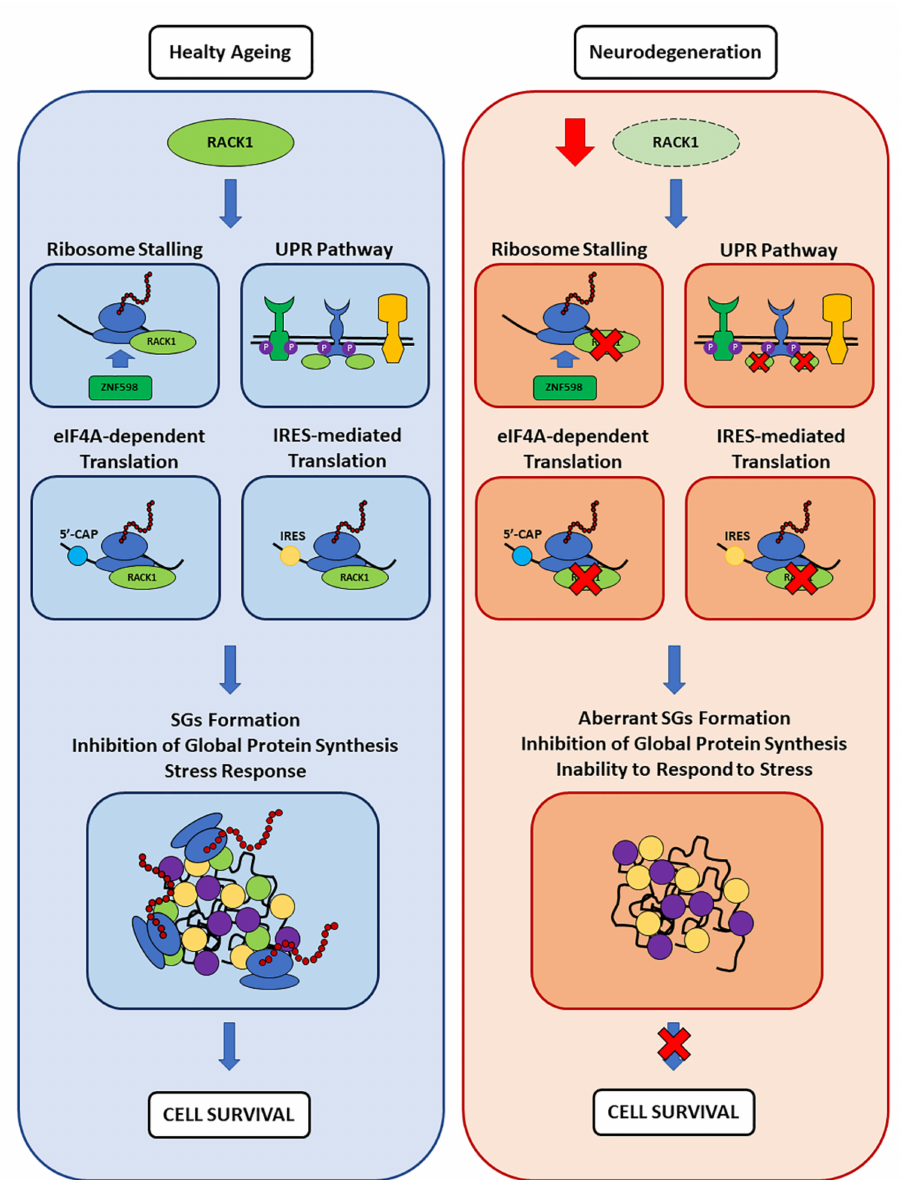
Figure 5. Proposed model of RACK1 ribosome- and translation-related roles in healthy aging and neurodegeneration, and its impact on SG-correlated functions . Here, RACK1 levels are reduced in AD patients compared to age-matched healthy controls [99,100] while its ribosome residency and stoichiometry are not altered during healthy aging [167]. Therefore, while RACK1 can contribute to the maintenance of proteostasis with its ribosomal and extra-ribosomal functions discussed here, its reduced levels in a pathological context can contribute to worsening the underlying proteostasis dysregulation observed in different neurodegenerative